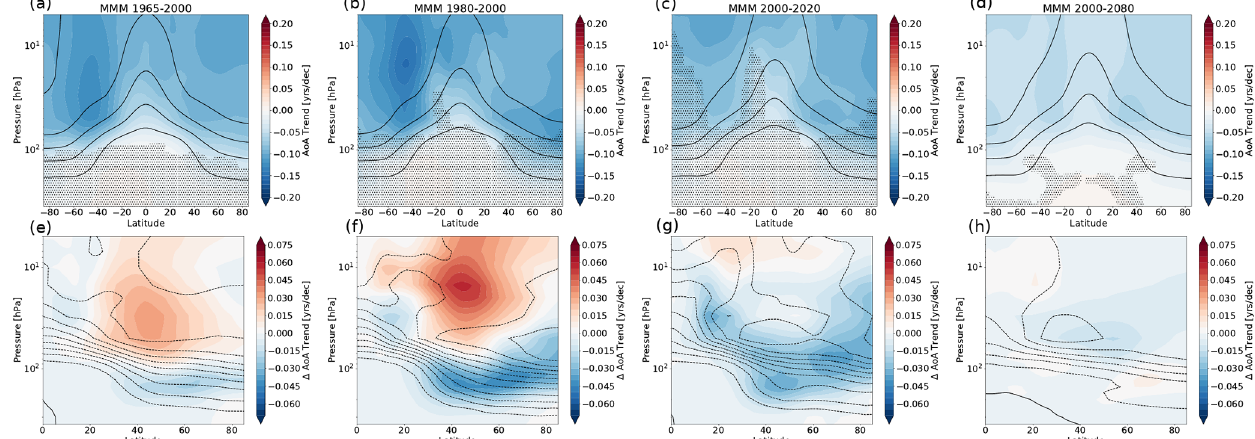
Figure 9. (a–d) Multi-model mean (MMM) trends in mean age from nine CCMI Ref-C2 model simulations for varying periods (see figure titles). (e–h) Hemispheric difference in the mean age trends. In the upper row, stippling indicates lack of significance of the trends (for the MMM trends, significance is detected if 2 / 3, i.e. six out of nine model simulations, show a significant trend). Thin black solid lines show climatological mean age, and dashed lines show NH